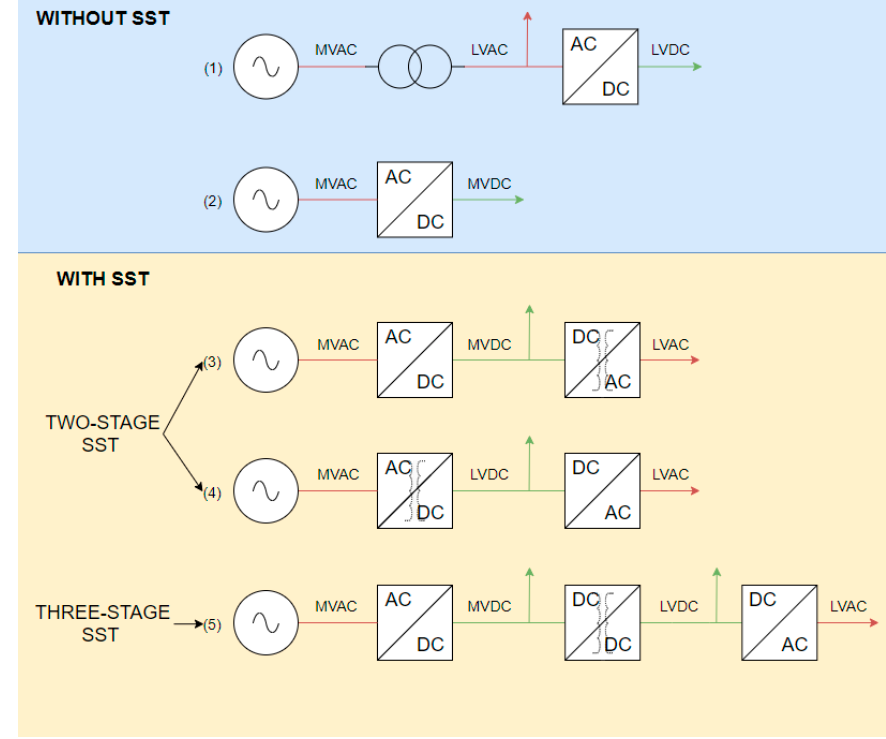
Figure 2 . Interfaces between the DC MG and the main grid. Figure 2. Interfaces between the DC MG and the main